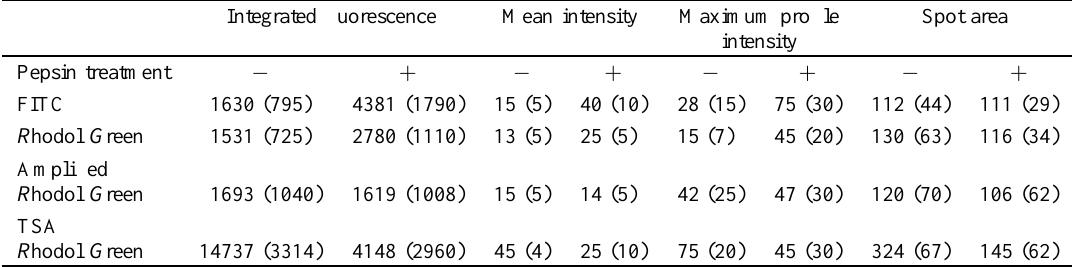
Table 2a Effect of pepsin treatment on signal characteristics